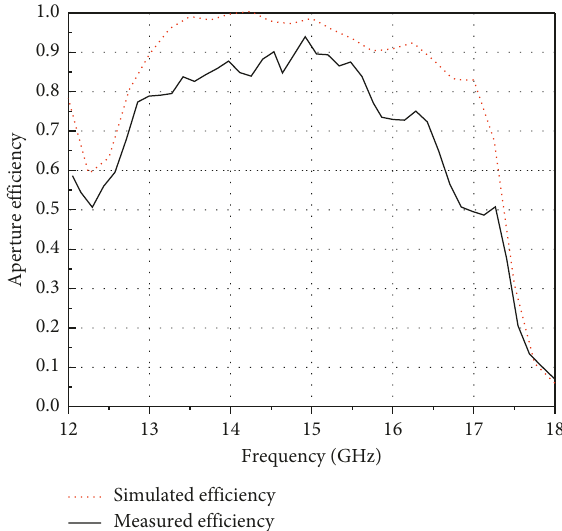
Figure 19: Simulated and measured aperture efficiency of the antenna array.